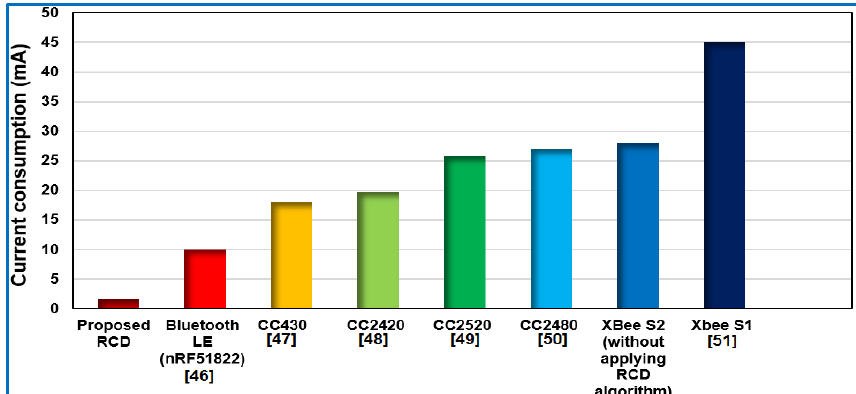
Figure 8. The current consumption of the sensor node compared with different wireless standard